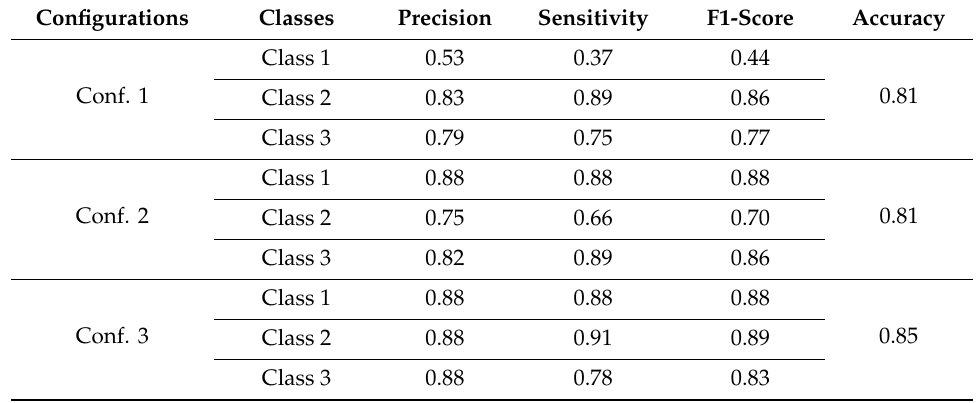
Table 6. The error performance (precision, sensitivity, F1-score, and accuracy) of general Least